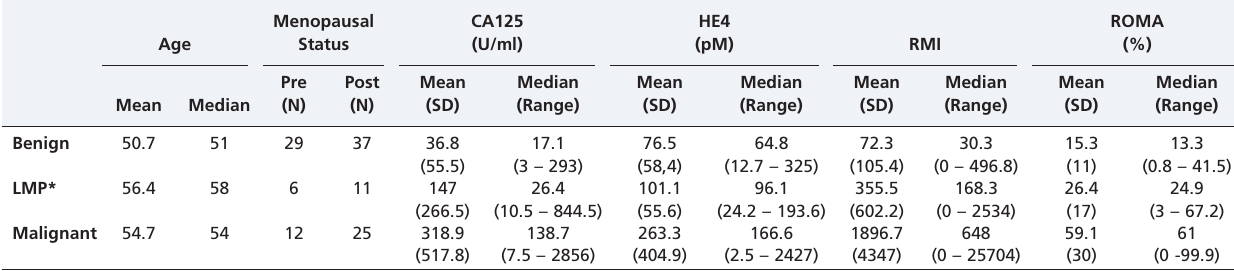
Table 1 - Characteristics of the studied population.